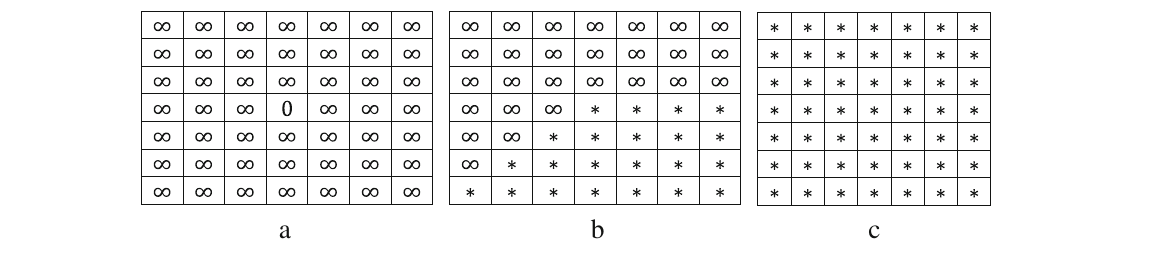
Fig. 9 First and second passes of the chamfer algorithm. The asterisk represents a real number. a Initialization. b Forward pass. c Backward